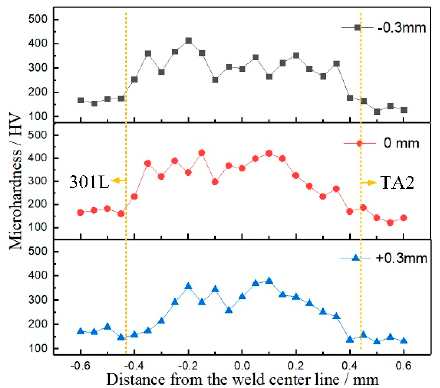
Figure 7. Microhardness distribution of 301L / TA2 welded joints.